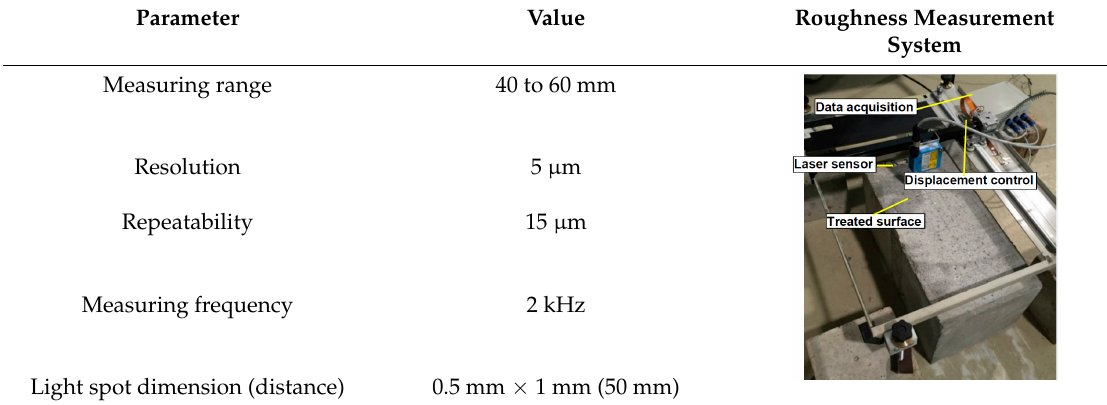
Table 1. Properties of laser sensor SICK OD2—N50W10U0 and roughness measurement system. Parameter